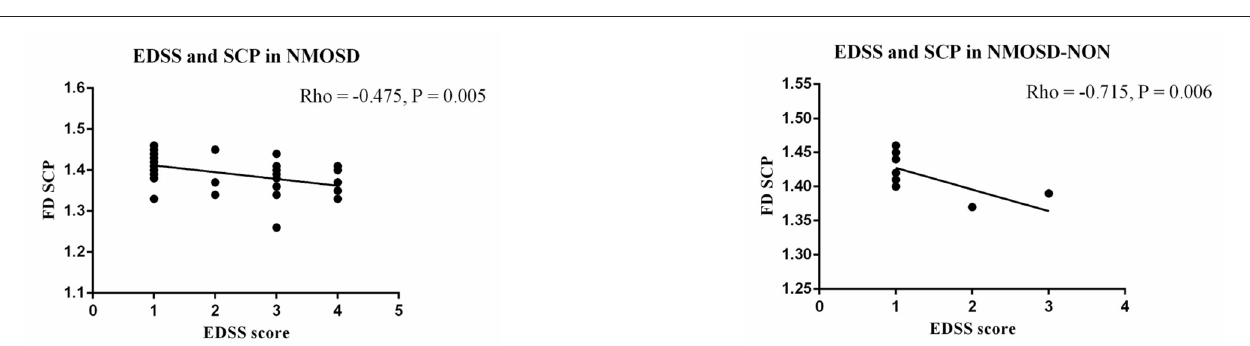
( p = 0.003, Table 2 ) of NMOSD patients when compared with healthy